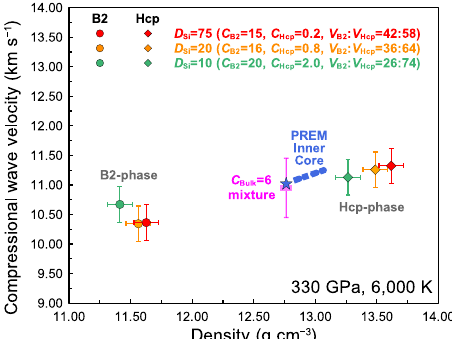
Fig. 6 Compressional wave velocity for the two-phase mixture of the B2 and hcp phases for a bulk silicon content of 6 wt% ( C Bulk = 6) at 330 GPa and 6000 K. A magenta rectangular symbol represents the averaged velocity (see Methods section) of the three models for two-phase mixtures shown in Fig. 5b. Symbols are same as those in Fig. 5b. The error bars represent 1 σ